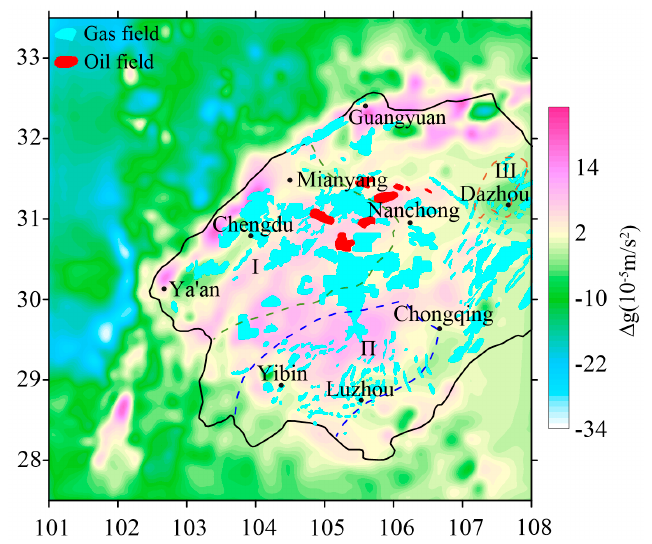
Figure 7. Residual anomaly and distribution features of the research area’s major oil and gas fields. ( Ι : Leshan–Longnvsi paleo–uplift; ΙΙ : Luzhou paleo–uplift; ΙΙΙ : Kaijiang paleo–uplift).